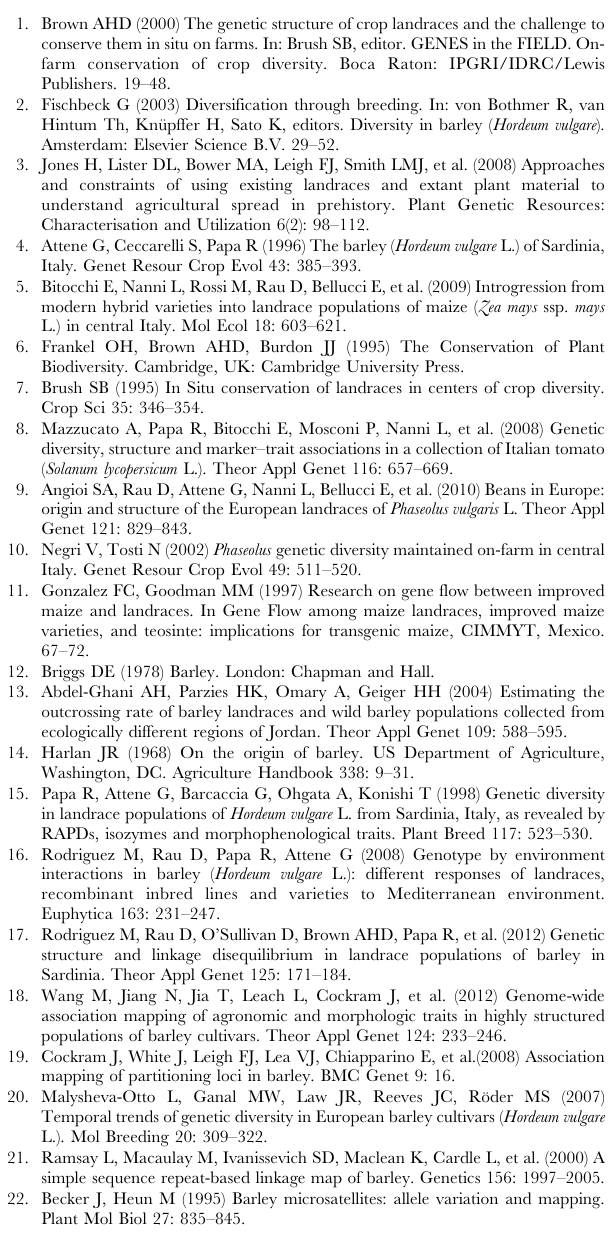
Table S2 Results of the Mantel test performed accord- ing to geographical distance (GeoDist), latutudinal distance (Latit), altitude (Altit) and rainfall (Rainf). ns,